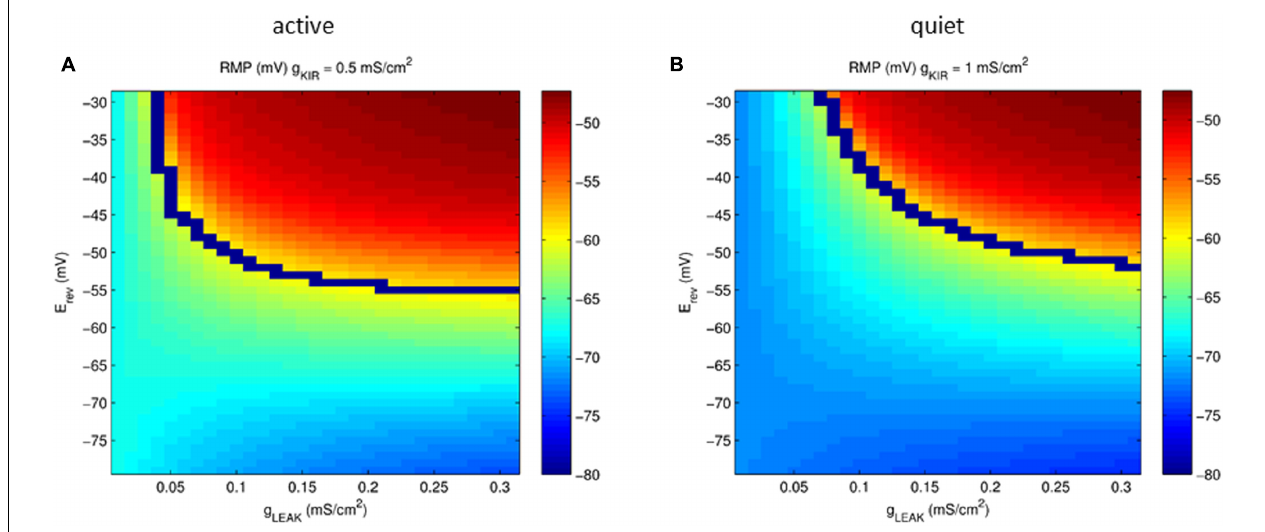
FIGURE 7 | Plot of the parameter space of the leak conductance versus reversal potential affecting RMP (color coded) in a model neuron with g Kir conductances typical of an active (A) and quiet (B) neuron. The blue line represents the transition from quiet (below) to active (above) firing